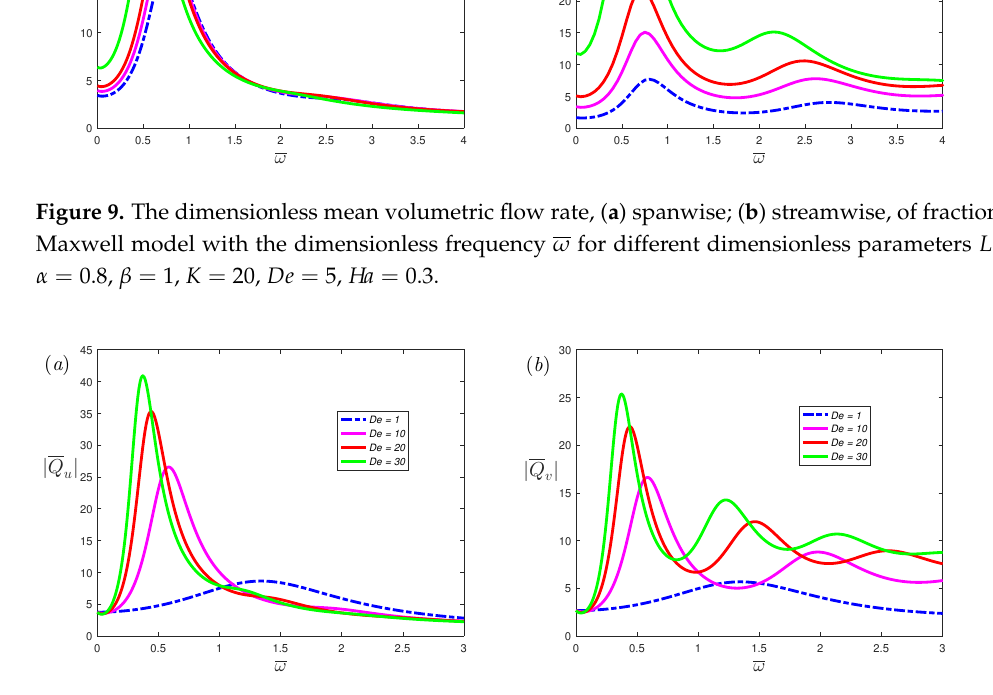
Figure 10. The dimensionless mean volumetric flow rate, ( a ) spanwise; ( b ) streamwise, of fractional Maxwell model with the dimensionless frequency ω for different dimensionless parameters De at α = 0.8, β = 1, K = 20, L = 0.03, Ha =